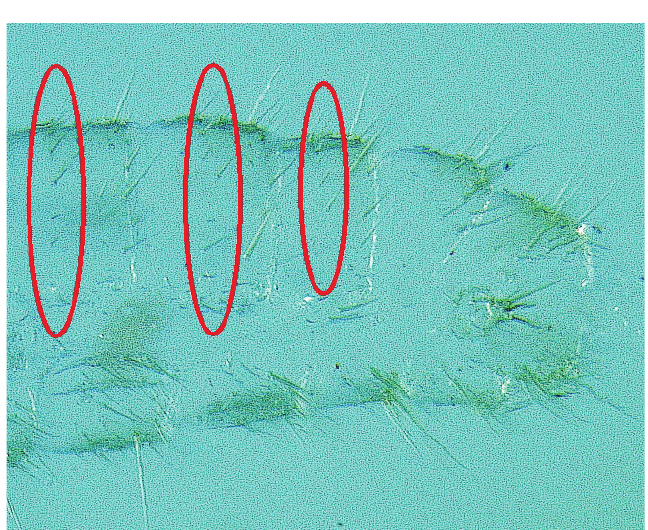
Figure 3. Posterior abdominal tergites of H. tenuis . Rows of long setae on central tergal surfaces are